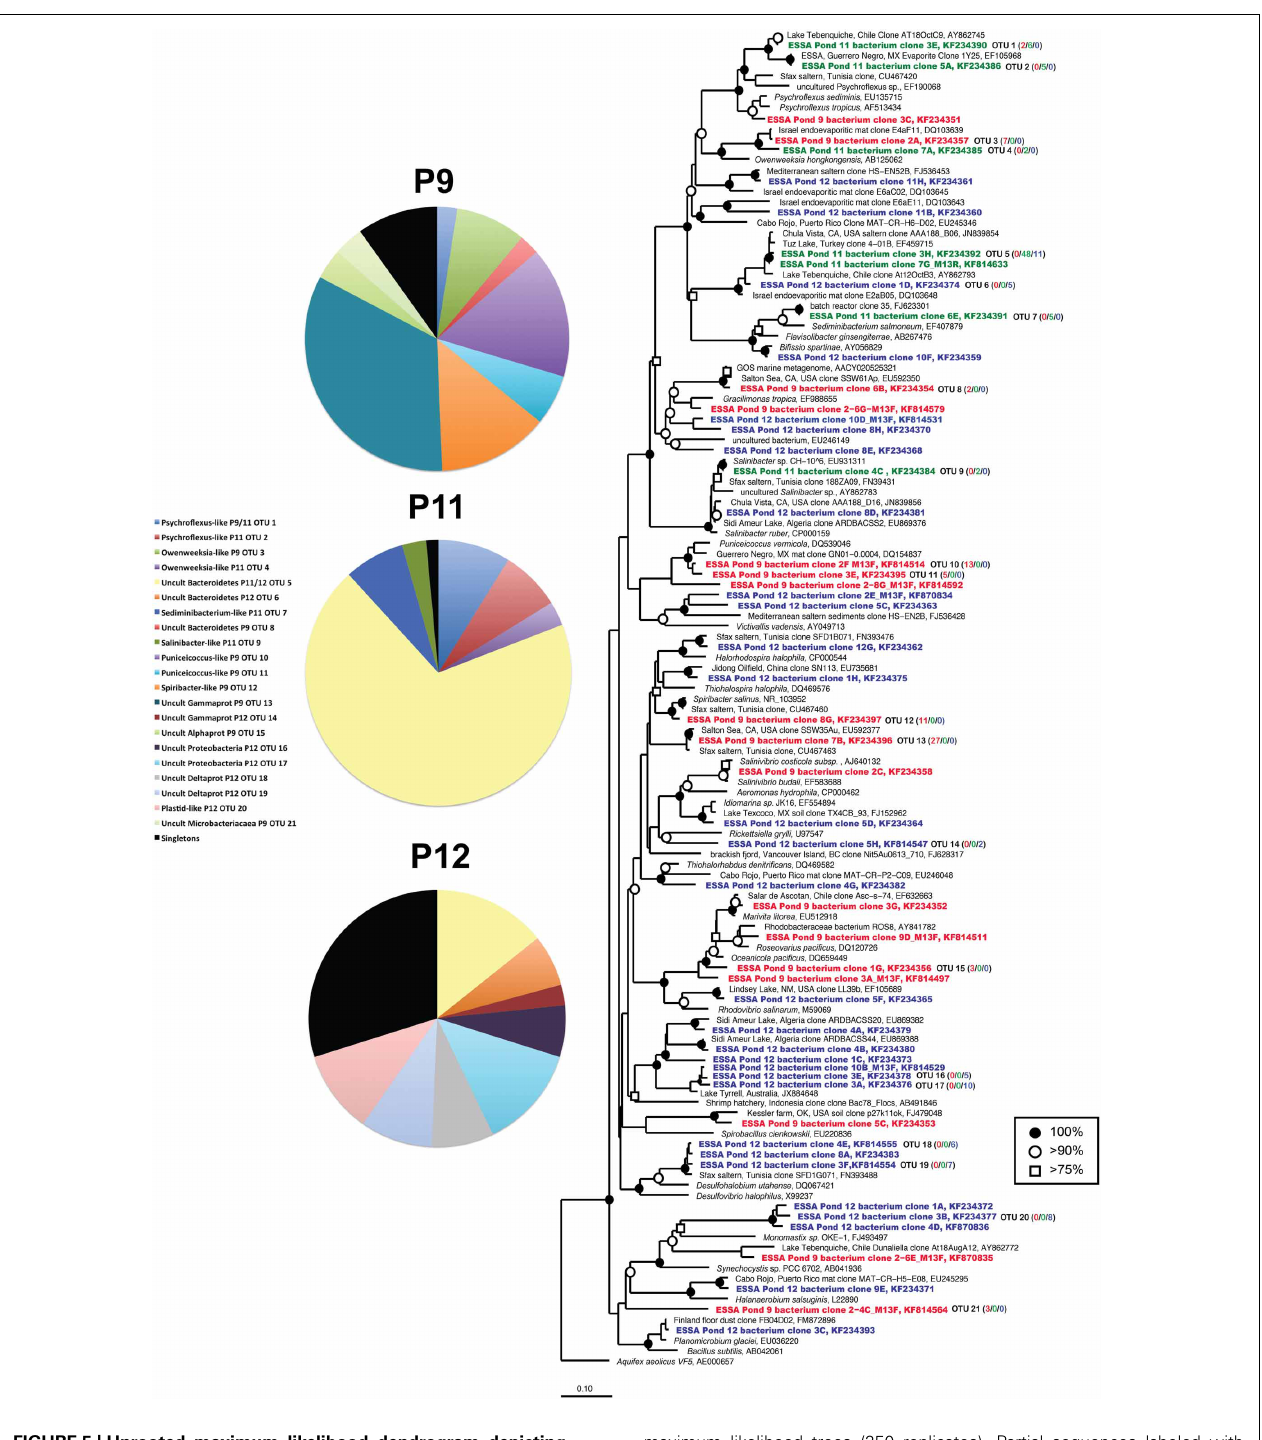
FIGURE 5 | Unrooted maximum likelihood dendrogram depicting relationships among representative bacterial 16 rRNA gene sequences at the 1% evolutionary difference level for clones obtained from the Ponds 9 (red), 11 (green), and 12 (blue) and closely related sequences. The tree was constructed using an alignment of 1033 nucleotide positions (gaps and ambiguous residues were excluded using a custom filter in ARB). Symbols at branches represent nodes with bootstrap support ≥ 75% ( (cid:2) ), 90% ( ◦ ), and 100% ( • ) for